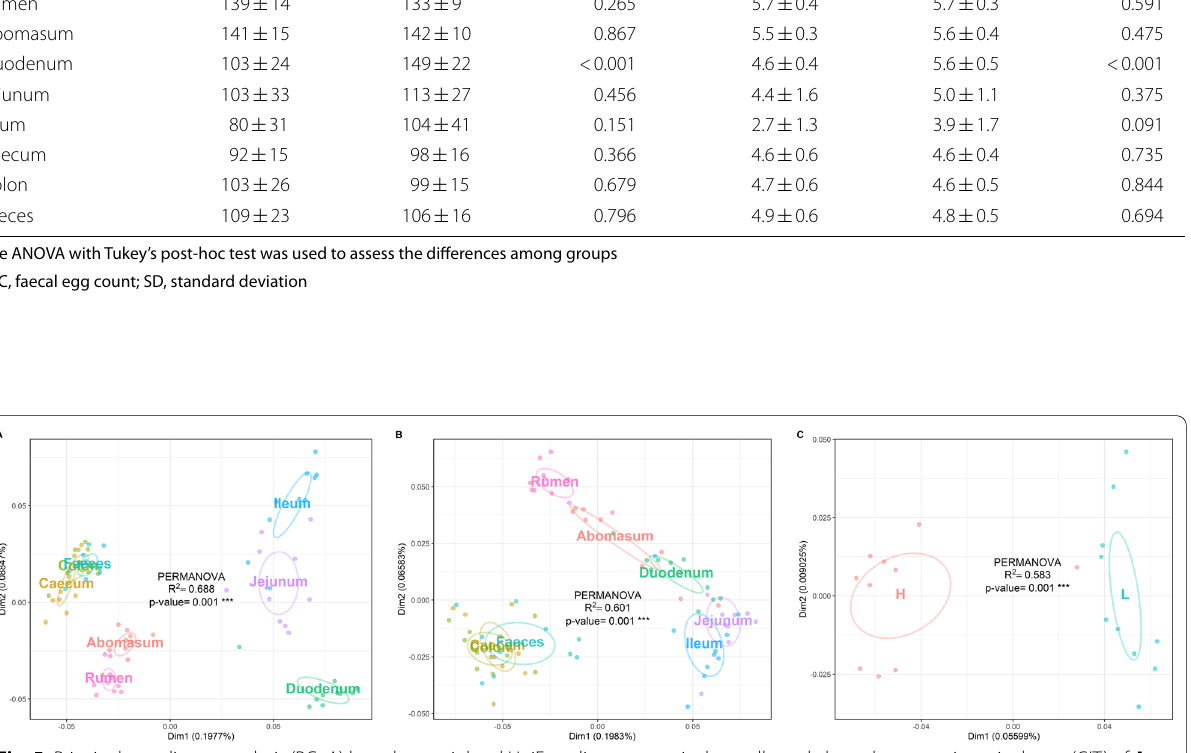
Table 1 Comparison of alpha diversity between High-FEC and Low-FEC groups in each gastro-intestinal tract segments